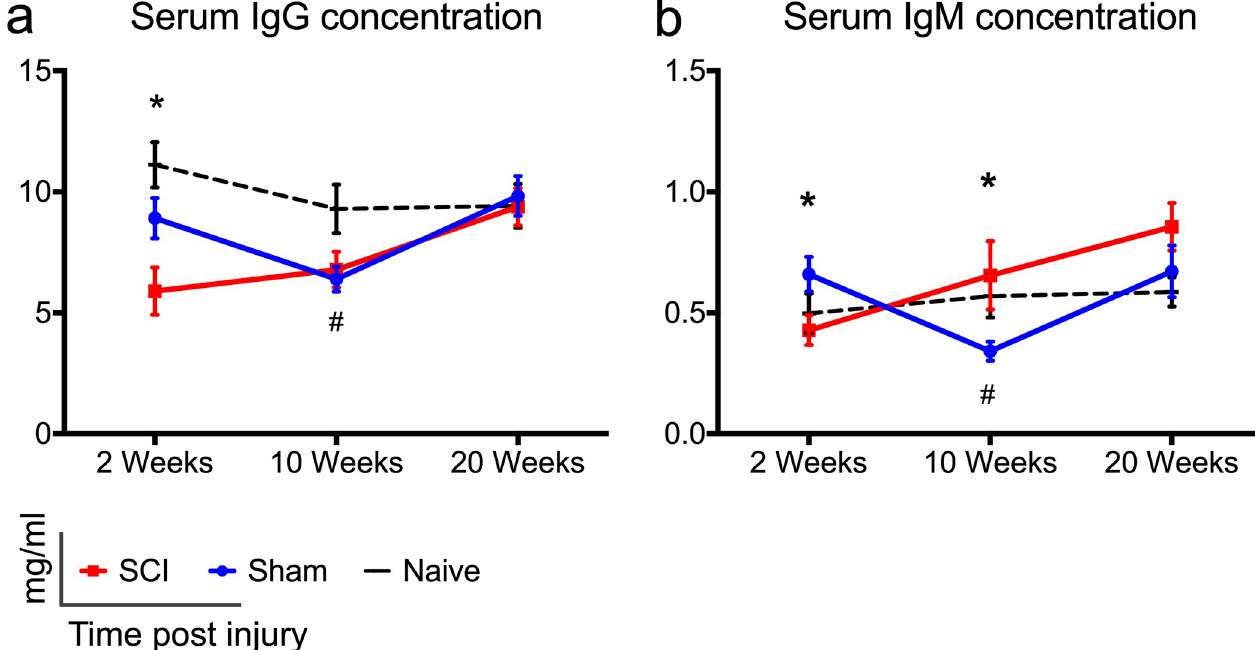
Fig 6. Changes in serum IgG and IgM immunoglobulin levels following cervical SCI. (a, b) Serum IgG and IgM levels declined significantly at 2 weeks post- cervical SCI compared to shams. In rats with cervical SCI, IgG immunoglobulin normalized to sham-levels at later time points. IgM levels were statistically higher in the SCI groups compared to shams at 10 weeks of injury. Na ï ve rats had significantly higher levels of IgG and IgM antibodies compared to sham rats at 10 weeks. One-way ANOVA with Holm-Sidak’s post-hoc test was performed for IgG data (2 weeks), and Kruskal Wallis analysis with Dunn’s multiple comparisons post-hoc tests were performed for all other data. � Indicates significant difference between sham and SCI groups, whereas # indicates significant difference between sham and na ï ve groups. � / # p < 0.05, N = 9–10 (SCI); 7–8 (Sham); 5–7 (Naive); rats/group, mean ± SEM.